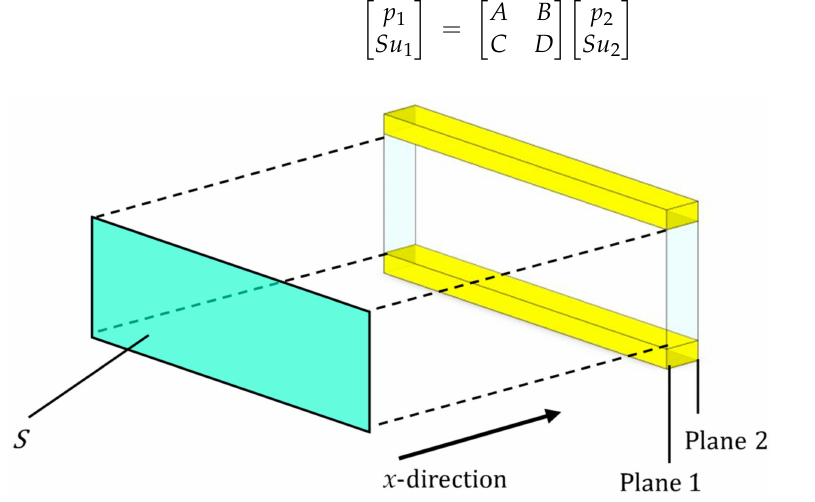
Figure 10. Sound incident area, incident plane, and transmission plane of approximated clearance between two planes in Figures 7b and